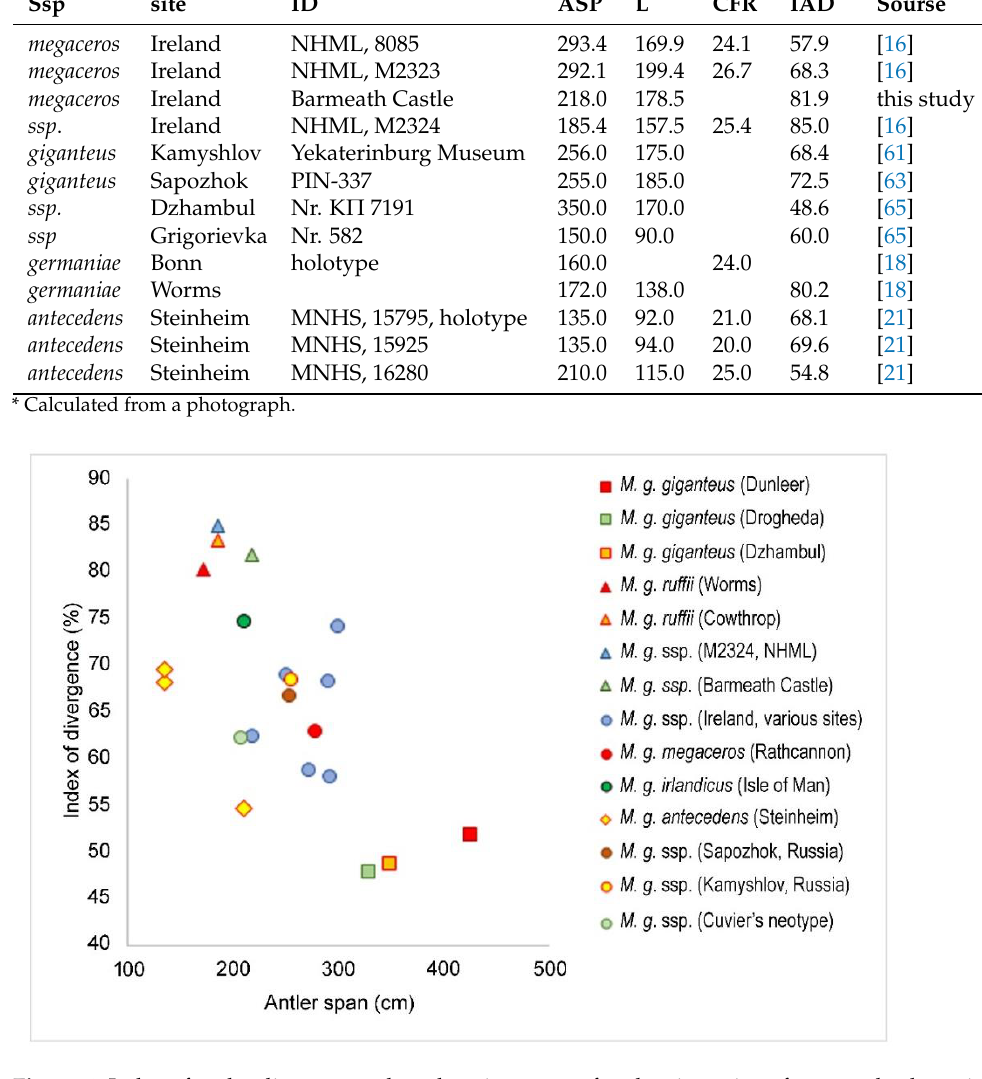
Figure 4. Index of antler divergence plotted against span of antlers in various forms and subspecies of Megaloceros giganteus .